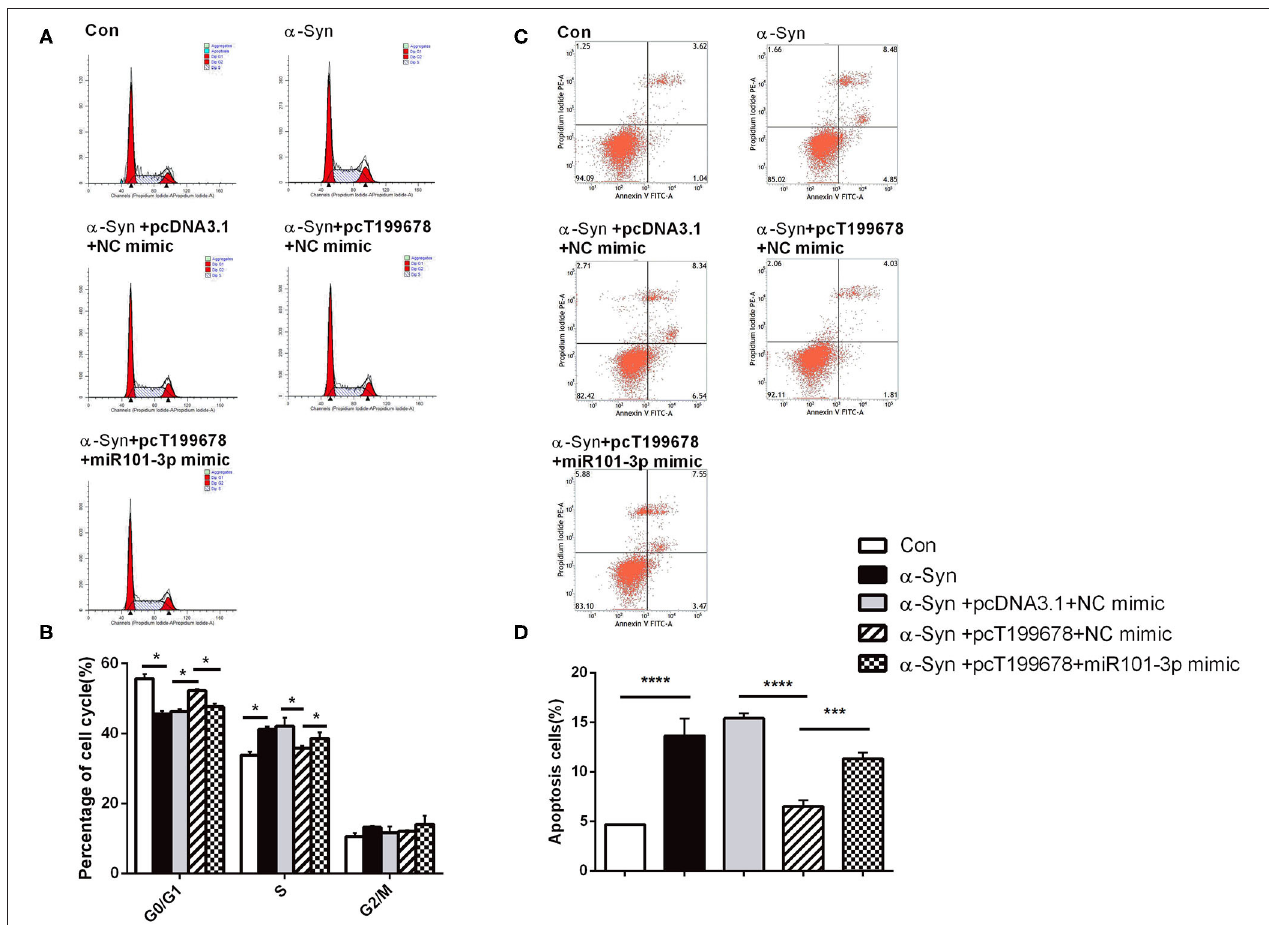
FIGURE 7 | lncRNA-T199678 mitigated α -Syn induced cell cycle abnormality and apoptosis via miR-101-3p . SH-SY5Y cells were divided into five groups: control (wild type), α -Syn, α -Syn + pcDNA3.1 + NC mimic, α -Syn + pcT199678 + NC mimic, and α -Syn + pc T199678 + miR-101-3p mimic. (A,B) The proportion of cells in the G0/G1, S, and G2/M phases in cell cycle via flow cytometry (both in the G0/G1 phase and S phase, one-way ANOVA, P < 0.01, followed by Tukey’s multiple-comparison tests: control vs. α -Syn, * P < 0.05; α -Syn + pcDNA3.1 + NC mimic vs. α -Syn + pcT199678 + NC mimic, * P < 0.05; α -Syn + pcT199678 + NC mimic, α -Syn + pc T199678 + miR-101-3p mimic, * P < 0.05). (C,D) Percentage of apoptotic cells was quantified using flow cytometry (one-way ANOVA, F = 76.52, df = 14, P < 0.0001, followed by Tukey’s multiple-comparison tests: control vs. α -Syn, **** P < 0.0001; α -Syn + pcDNA3.1 + NC mimic vs. α -Syn + pcT199678 + NC mimic, **** P < 0.0001; α -Syn + pcT199678 + NC mimic, α -Syn + pc T199678 + miR-101-3p mimic,*** P <